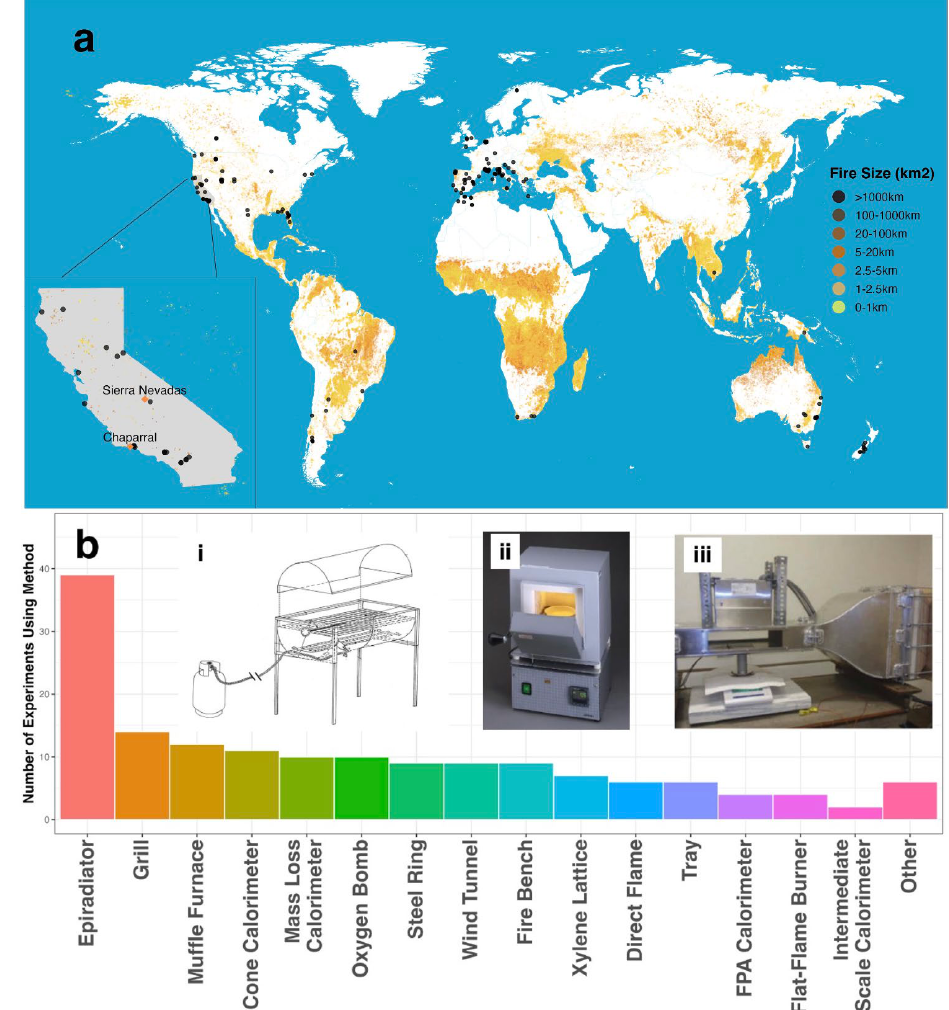
Figure 2. ( a ) Map showing the sampling locations of studies included in the literature review (black points), global ignition data from 2015 and 2016 (Global Fire Data), and the corresponding fire size for each fire (shown in a gradient from orange to red). Points vary in their geographical accuracy, as some studies present specific coordinates, while others present broad regions. A total of 13/134 studies did not provide a location specific enough to include on this map. Included also, is an inset map of California showing sampling sites as identified by the literature review as well as our sampling sites (shown with orange diamonds) ( b ) The number of experiments using each of 16 methods across 134 studies investigated by the literature review. Shown also, are images of 3 commonly used methods (( i ): grill [11]; ( ii ): muffle furnace [22]; ( iii ): wind tunnel [23]). For descriptions of each method, see Table A1 or